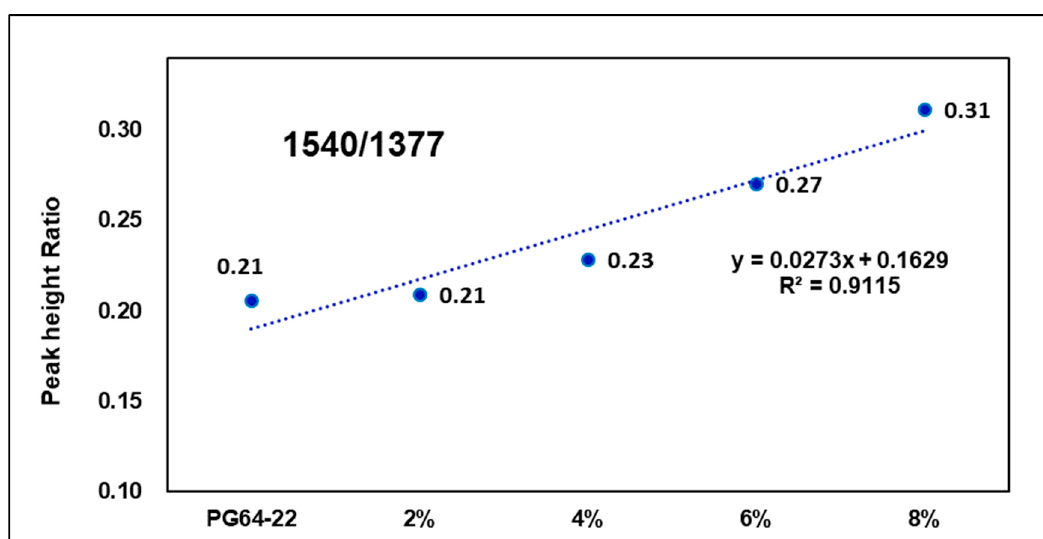
Figure 17. Warm-mix additives modified binder peak ratio (1540/1377).